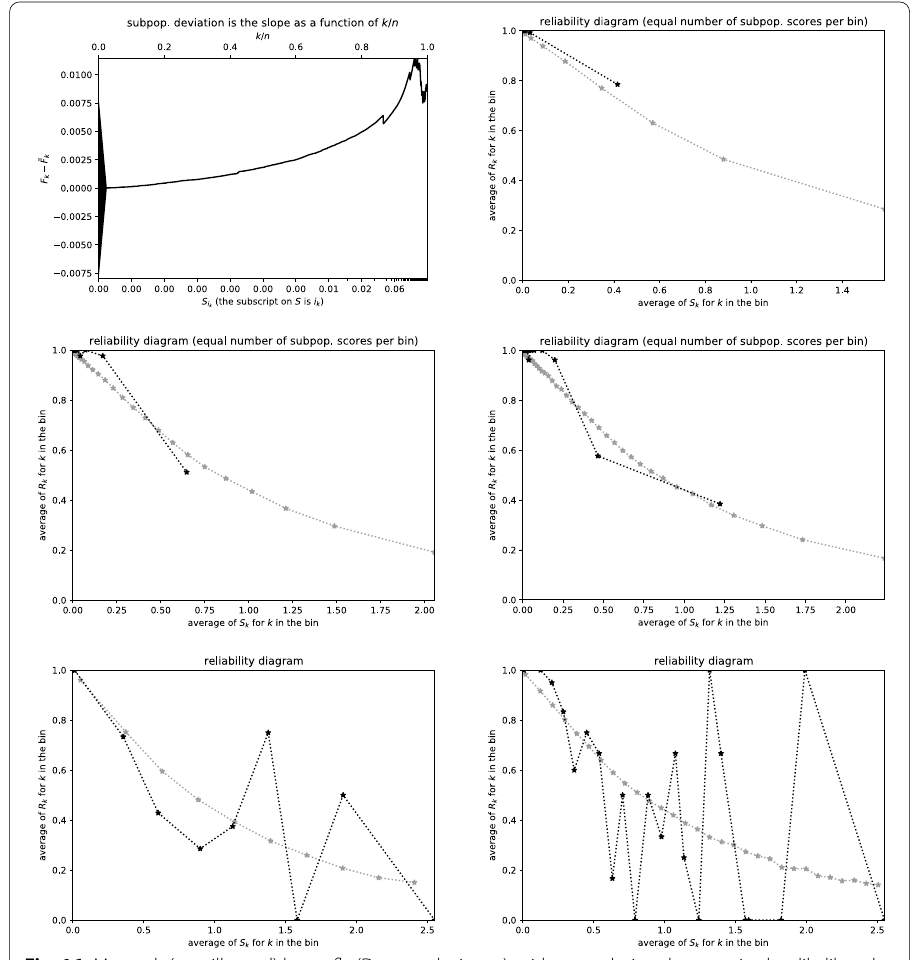
deviation of the subpopulation below the full population that occurs for scores greater than 1.5 is apparent only in the cumulative plot or in the (very noisy) reliability diagrams whose bins are roughly equispaced along the scores. The scalar summary statistics detect somewhat significant deviation, but not as much as would be possible if the Kolmogorov-Smirnov and Kuiper metrics were to take fully into account the steep drop that occurs in the plot of cumulative